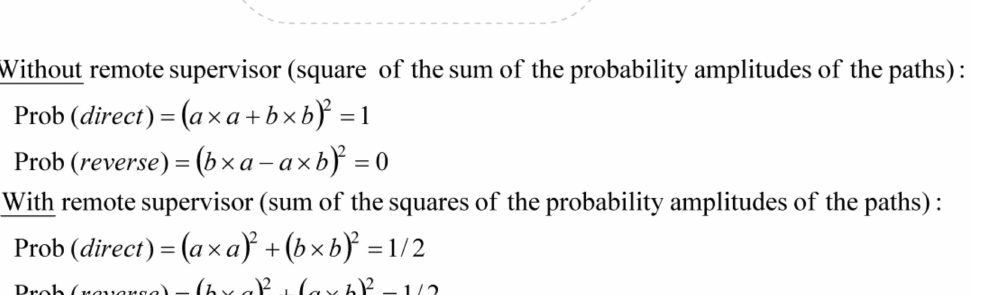
Figure 5. Quantum-like logic of the emerging relationship. The underlying logic of the relationship that emerges in the model is isomorphic to Young’s two-slit experiment. In Young’s two-slit experiment, the screen interferences disappear if the paths of photons are detected. In the model, the relationship between labels and system states is no better than random (i.e., equal to 1/2) if the relationship of labels with system states is assessed by a remote